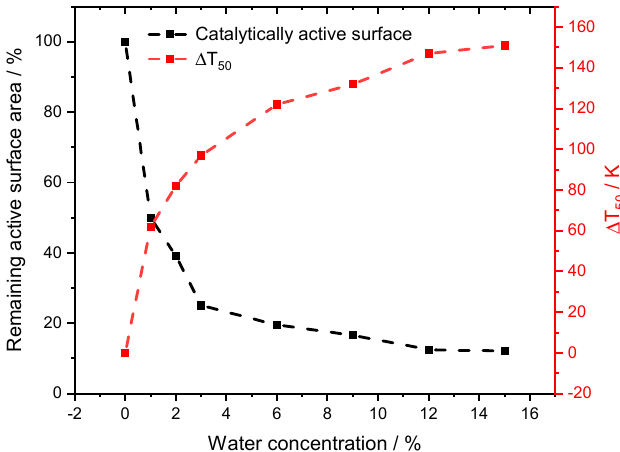
Figure 6. Results for the obtained change of the catalytically active surface area in comparison to